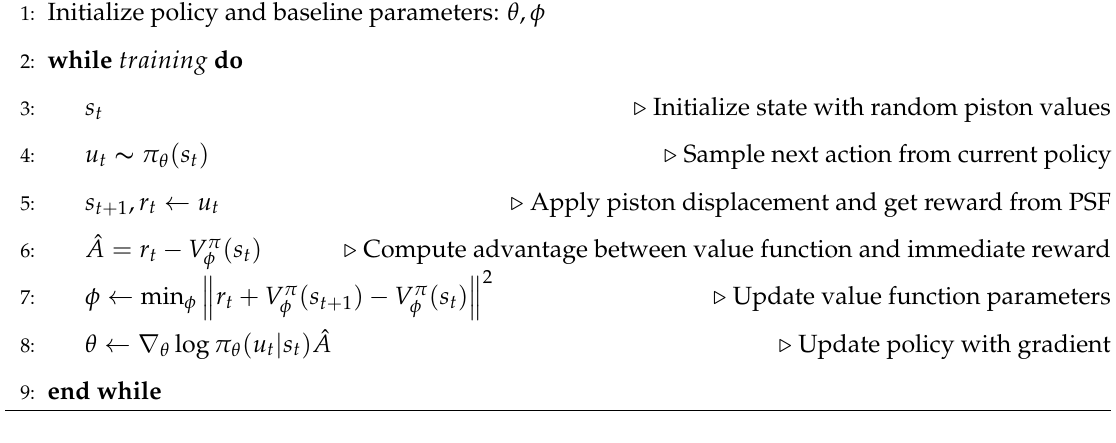
Algorithm 1 Policy gradients with value function baseline